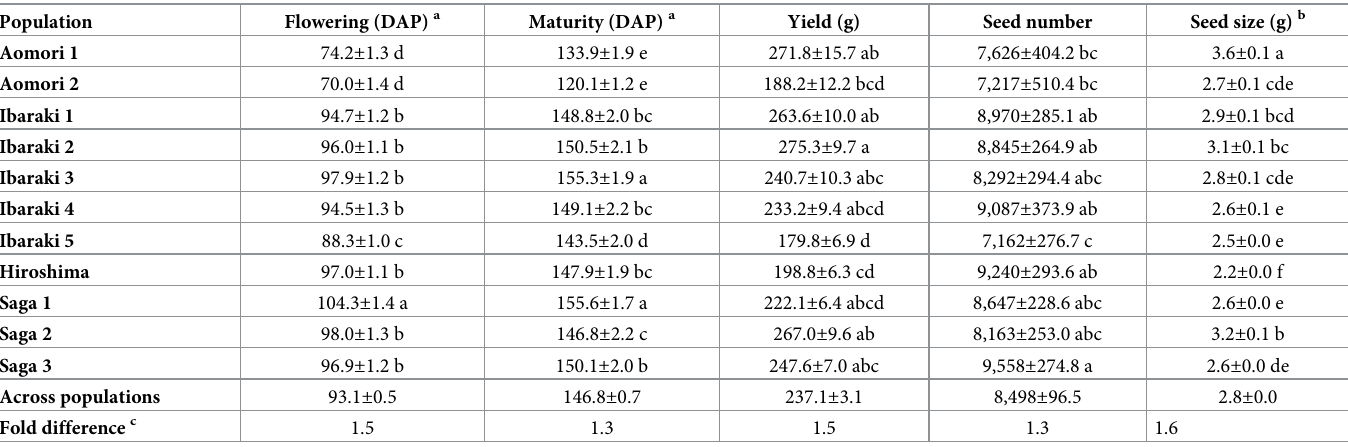
Table 3. Wild soybean values (mean ± SE) for flowering, maturity, yield per plant, seed number per plant, and seed size under favorable growing conditions.